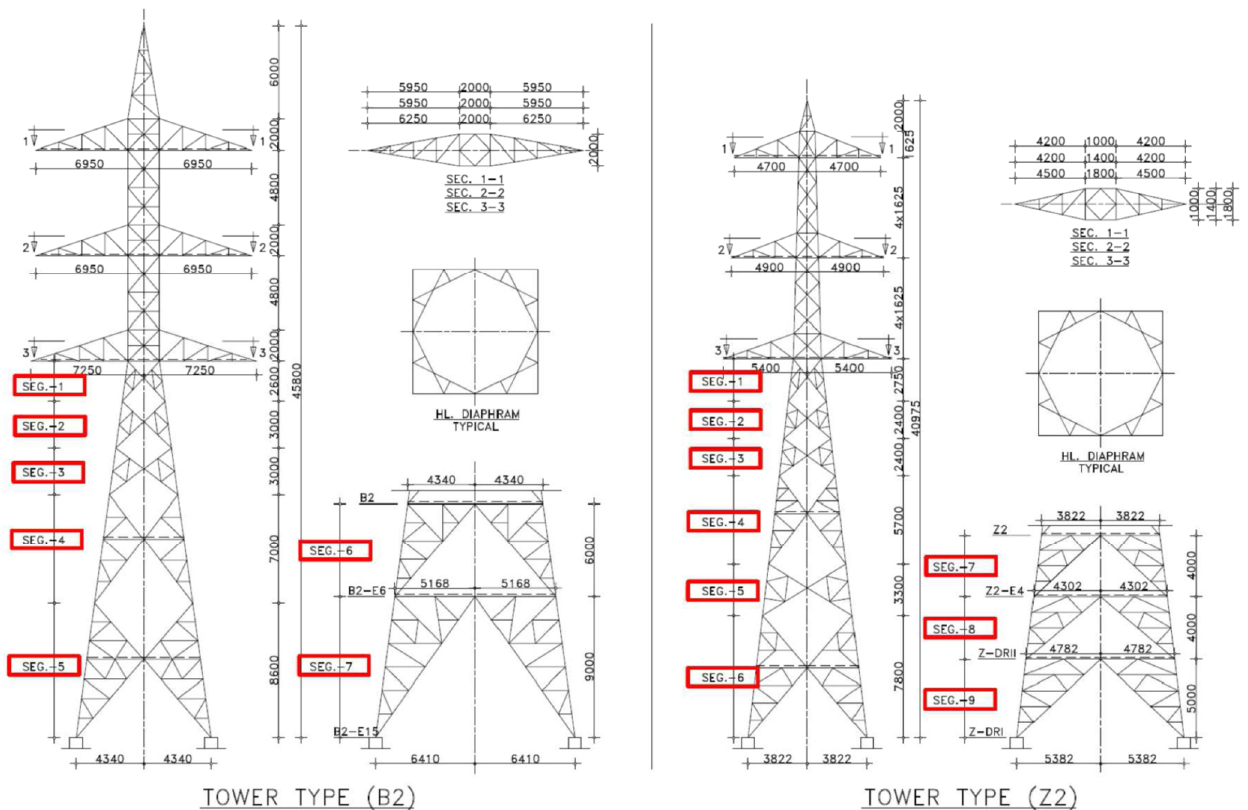
Figure 6. Line diagram of verification tower types: B2 and Z2. Table 6. Summary of the verification results.